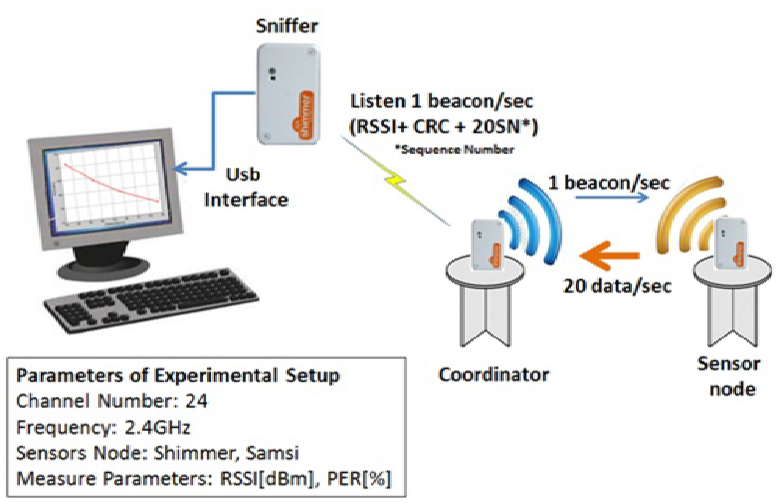
Figure 1. Experimental